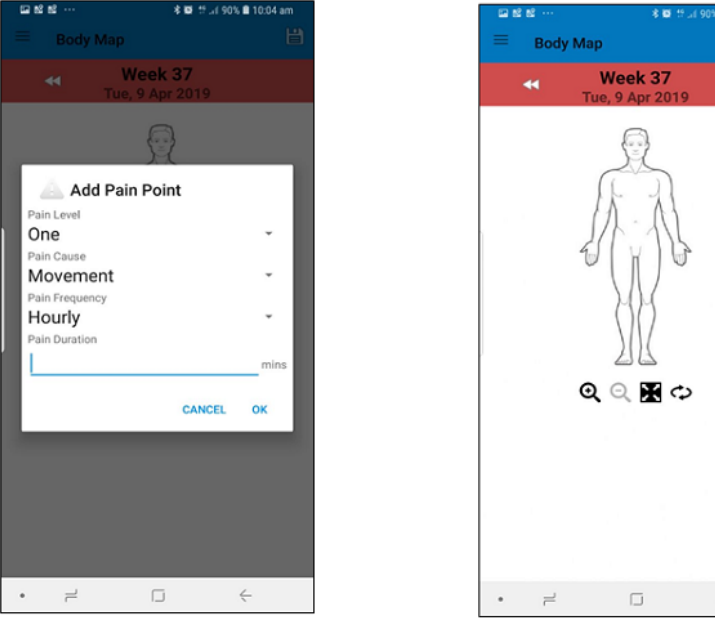
Figure 6. Body pain map screen on Android